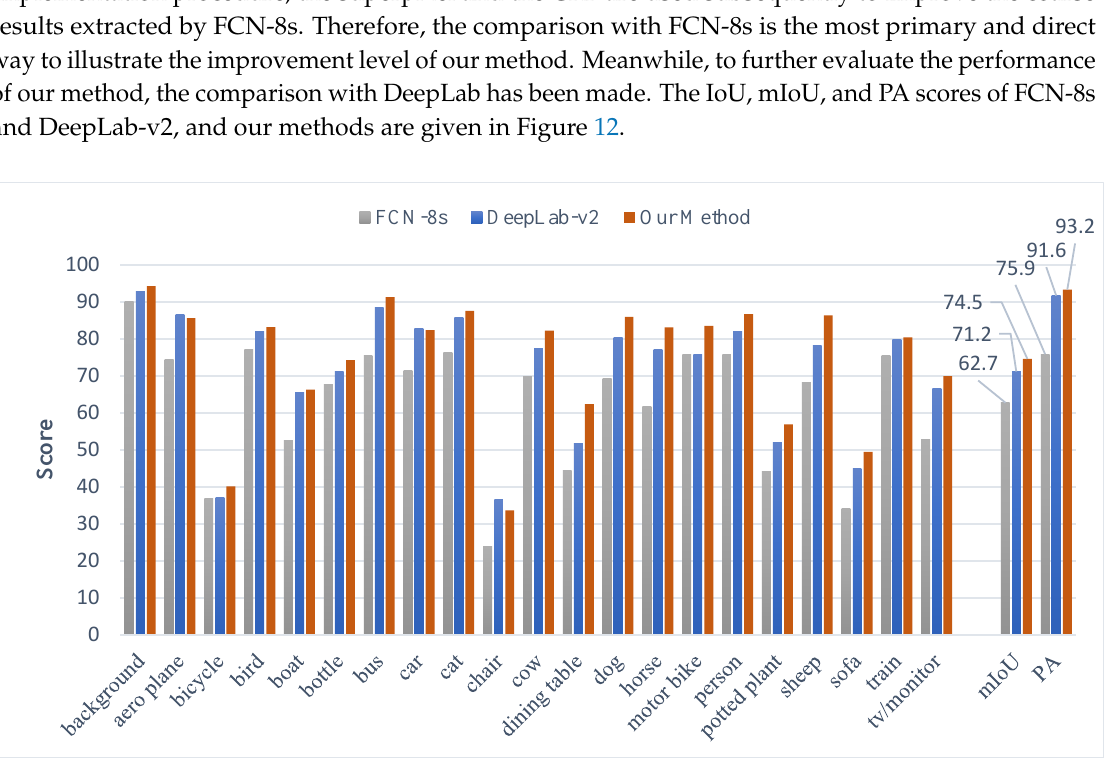
Table 2. Per-class IoU score on VOC dataset. Best performance of each category is highlighted in bold.